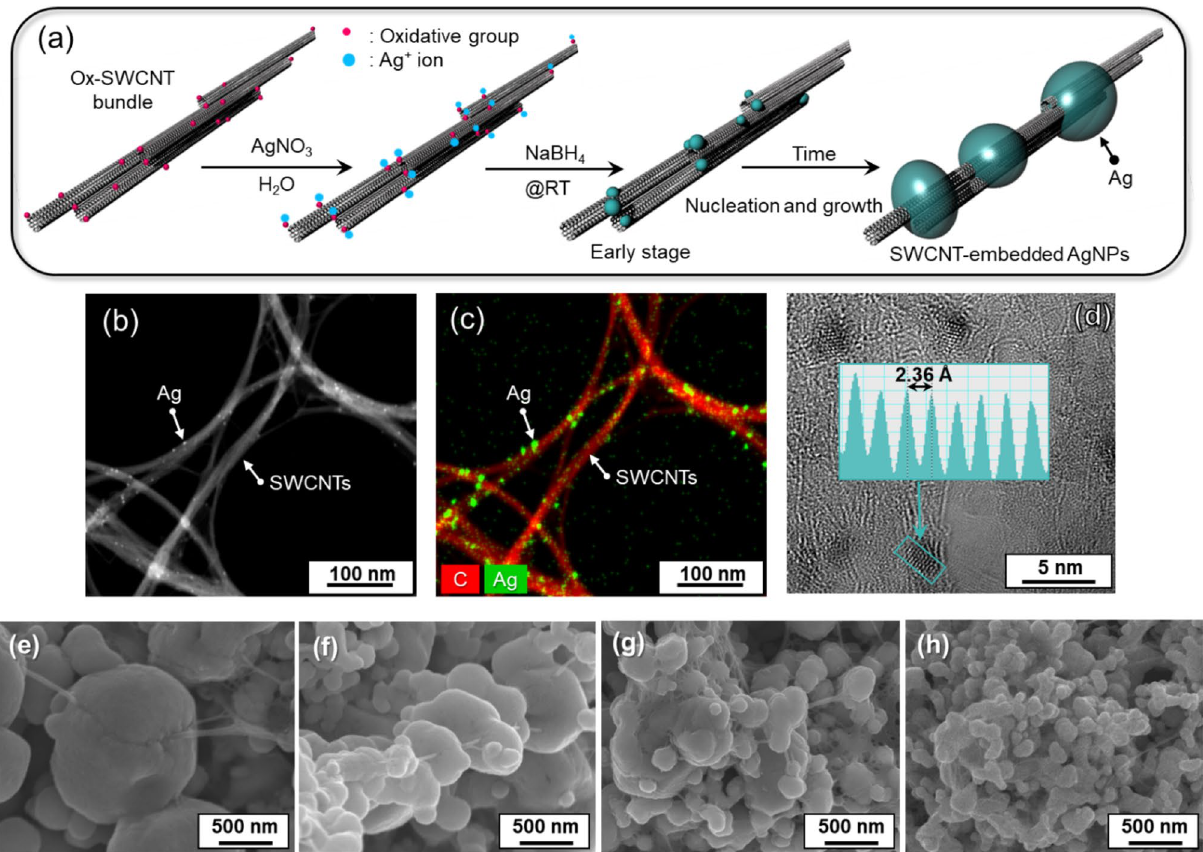
Figure 2. ( a ) Schematics of synthesis of SWCNT-embedded AgNPs. ( b ) TEM image analysis of SWCNTs decorated with tiny Ag particles nucleated by oxidative functional groups at early stage: ( c ) EDS mapping image of Ag and carbon, ( d ) High resolution TEM image and d-spacing line profile of Ag nuclei crystal (inset). FESEM images of SWCNT-embedded AgNPs by varying the concentration of AgNO 3 in the solution; ( e ) 0.08 M, ( f ) 0.06 M, ( g ) 0.04 M, ( h ) 0.02